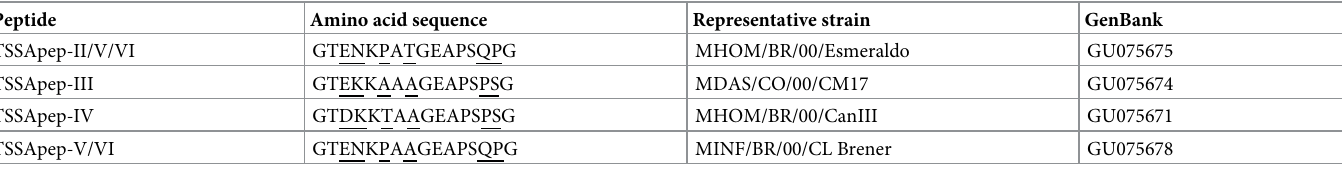
Table 1. Trypanosoma cruzi lineage-specific peptides (TSSApep) used in serology. Peptide Amino acid sequence Representative